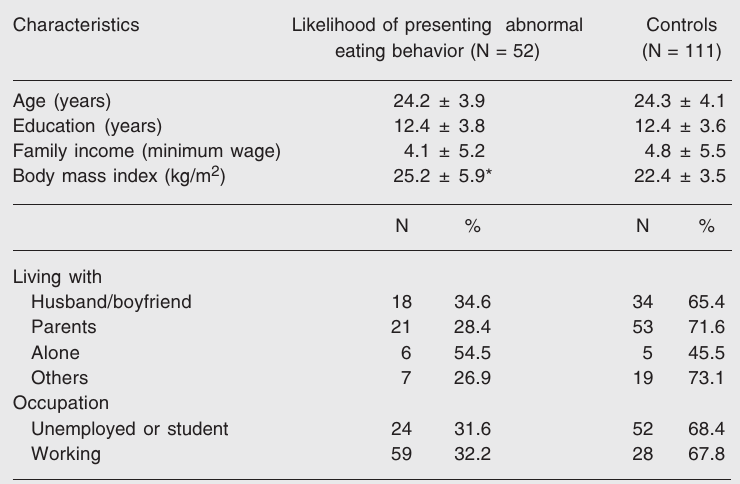
Table 2. Sociodemographic characteristics of women likely to present abnormal eating behavior from Porto Alegre, Brazil, 2002 (N = 163).